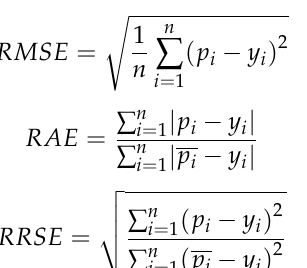
Table 2. Error comparison between the ANN algorithms.